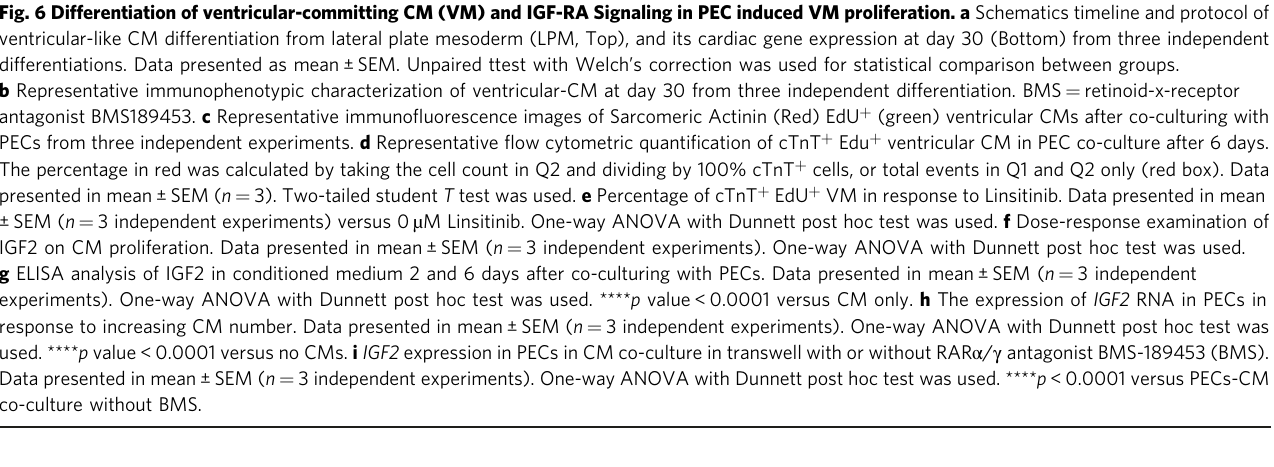
Fig. 6 Differentiation of ventricular-committing CM (VM) and IGF-RA Signaling in PEC induced VM proliferation. a Schematics timeline and protocol of ventricular-like CM differentiation from lateral plate mesoderm (LPM, Top), and its cardiac gene expression at day 30 (Bottom) from three independent differentiations. Data presented as mean ± SEM. Unpaired ttest with Welch ’ s correction was used for statistical comparison between groups.